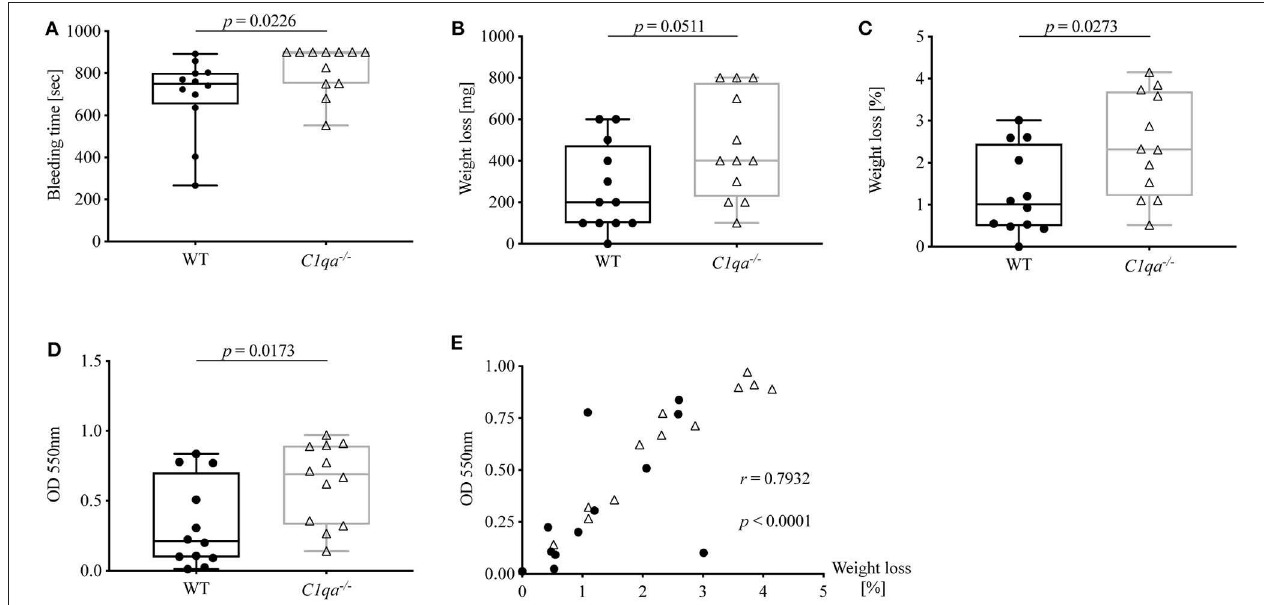
FIGURE 4 | Bleeding tendency of C1q-deficient vs. WT mice. Tail bleeding assay was performed and bleeding tendency of C1q-deficient and WT mice assessed by (A) bleeding time, (B) weight loss, (C) relative weight loss normalized to the total body weight and (D) OD of obtained blood-PBS solution. (E) Correlation between OD and relative weight loss is depicted. Horizontal lines in the box plots denote median while the boxes indicate interquartile range and whiskers minimum and maximum values. Data points represent individual mice, n = 12 per group (Mann–Whitney test; r , Spearman’s rank correlation